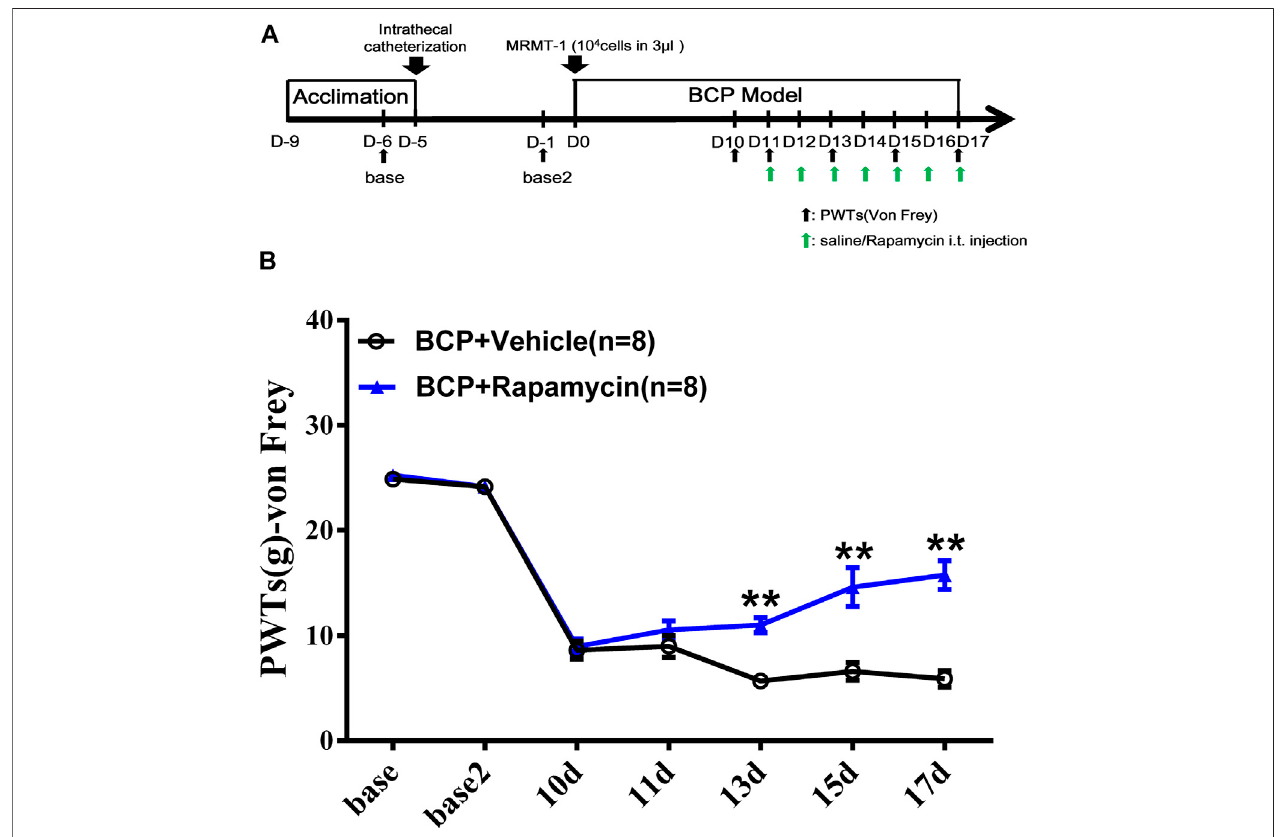
FIGURE 8 | Administration of mTOR inhibitor rapamycin alleviated the mechanical hyperalgesia of BCP rats. (A) Animal experiment procedure for mTOR inhibition inBCPrats; (B) time-coursechangeofPWTsinrats.ThePWTsintheBCP+rapamycingroupdecreasedondays13,15,and17aftertumorcellinoculation.Compared withtheBCP+vehiclegroup,thePWTsofBCP+rapamycingroupincreasedonpostoperativedays13,15,and17.** p < 0.01,comparedwiththeBCP+vehiclegroup.